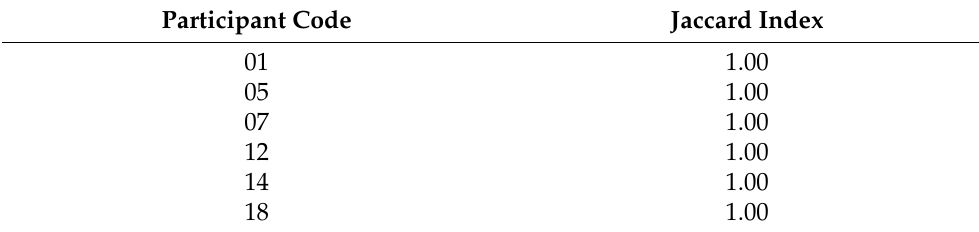
Table 2. Results of the first round.